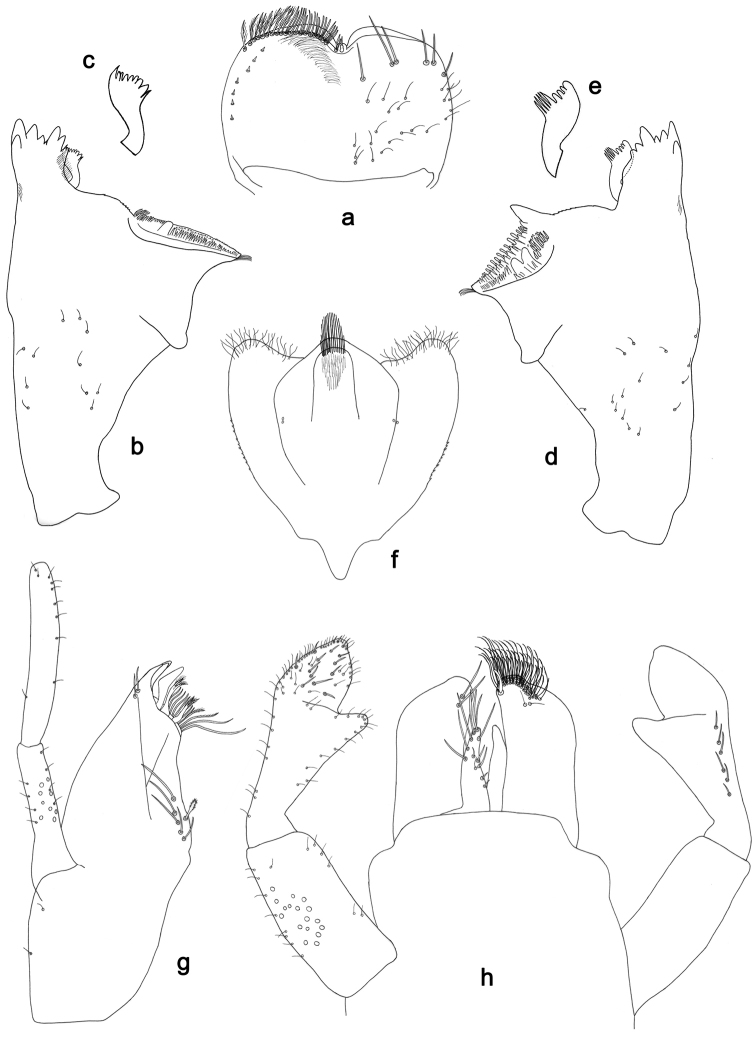
Labiobaetisparavitilis sp. n., larva morphology: a Labrum b Right mandible c Right prostheca d Left mandible e Left prostheca fHypopharynxg Maxilla h Labium.